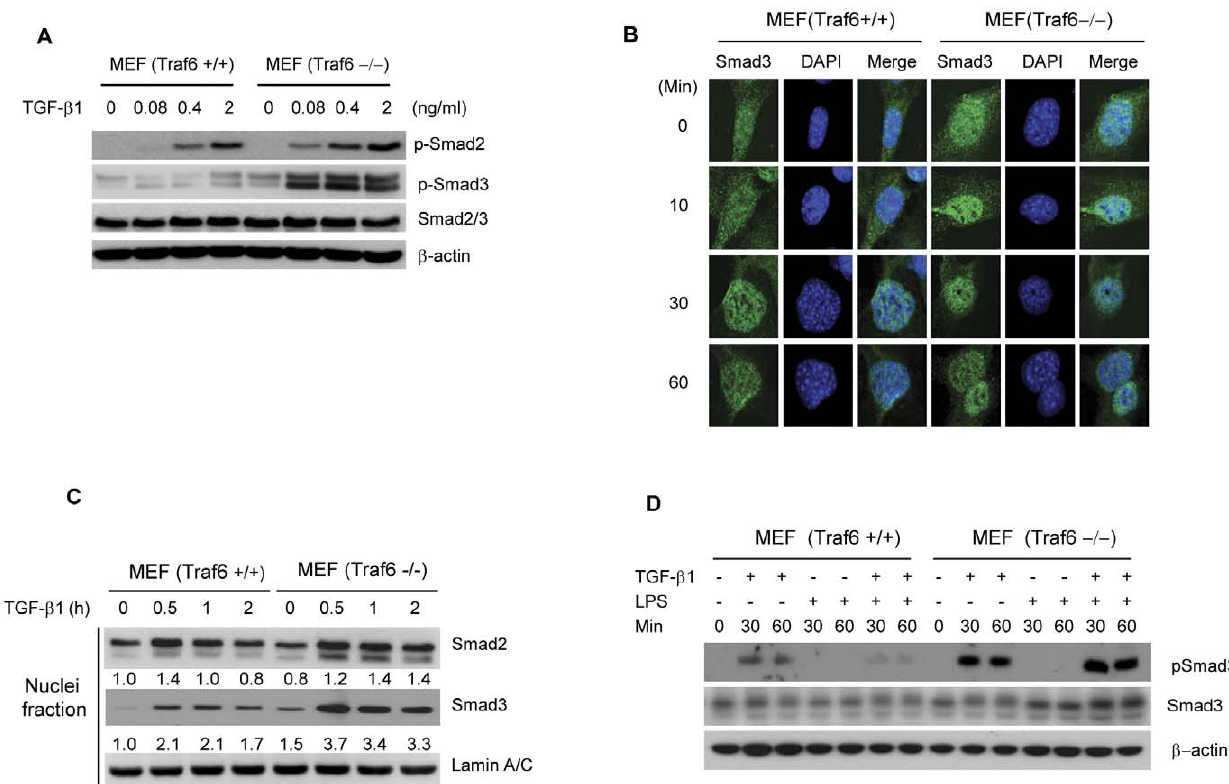
Figure 2. Traf6 -deficient primary cells show a higher sensitivity to TGF- b 1. ( A ) Wild-type and Traf6 2 / 2 MEFs were grown in 6-well plates and harvested for immunoblotting. TGF- b 1 sensitivity in Traf6 + / + and Traf6 2 / 2 MEF cells were depicted by comparing pSmad2/3 post treatment of various dose of TGF- b 1. ( B ) Cells were treated with TGF- b 1 (0.4 ng/ml) for the indicated time and immunostaining was carried out as described in materials and methods using an anti-Smad3 antibody. DAPI staining illustrated the compartment of nuclei. ( C ) The nuclei fractions were isolated from MEFs treated with TGF- b 1 in a time course up to 2 hours. Lamin A/C from the nuclear fraction indicated equal loading. Density of detected Smad2 and Smad3 was normalized by lamin A/C and is shown as fold increase. ( D ) Wild-type and Traf6 -deficient MEFs were treated with TGF- b 1 and/or LPS as indicated and then the level of p-Smad3 and I k B a were compared. I k B a degradations by LPS were observed only in the Traf6 + / + MEF, but not in the Traf6 2 / 2 MEF. The results are representative of three independent